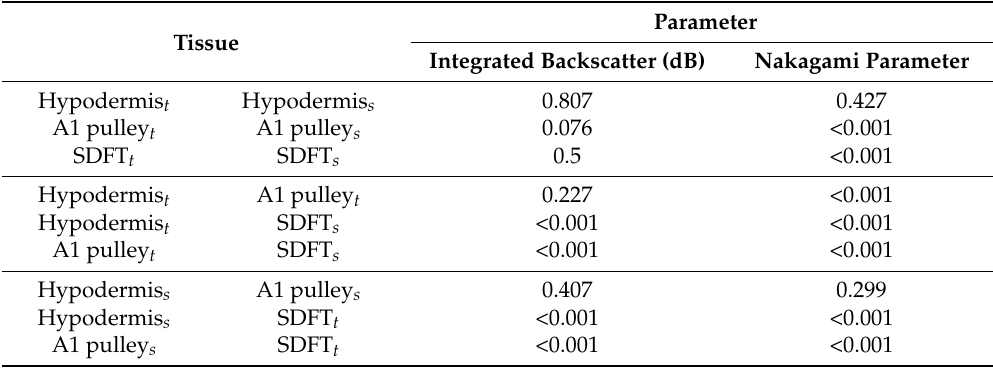
Table 2. The p value of the integrated backscatter and Nakagami parameter with different tissues acquired in the transverse and sagittal planes. The subscript of t and s indicate direction of images acquired from the transverse plane and sagittal plane, respectively.